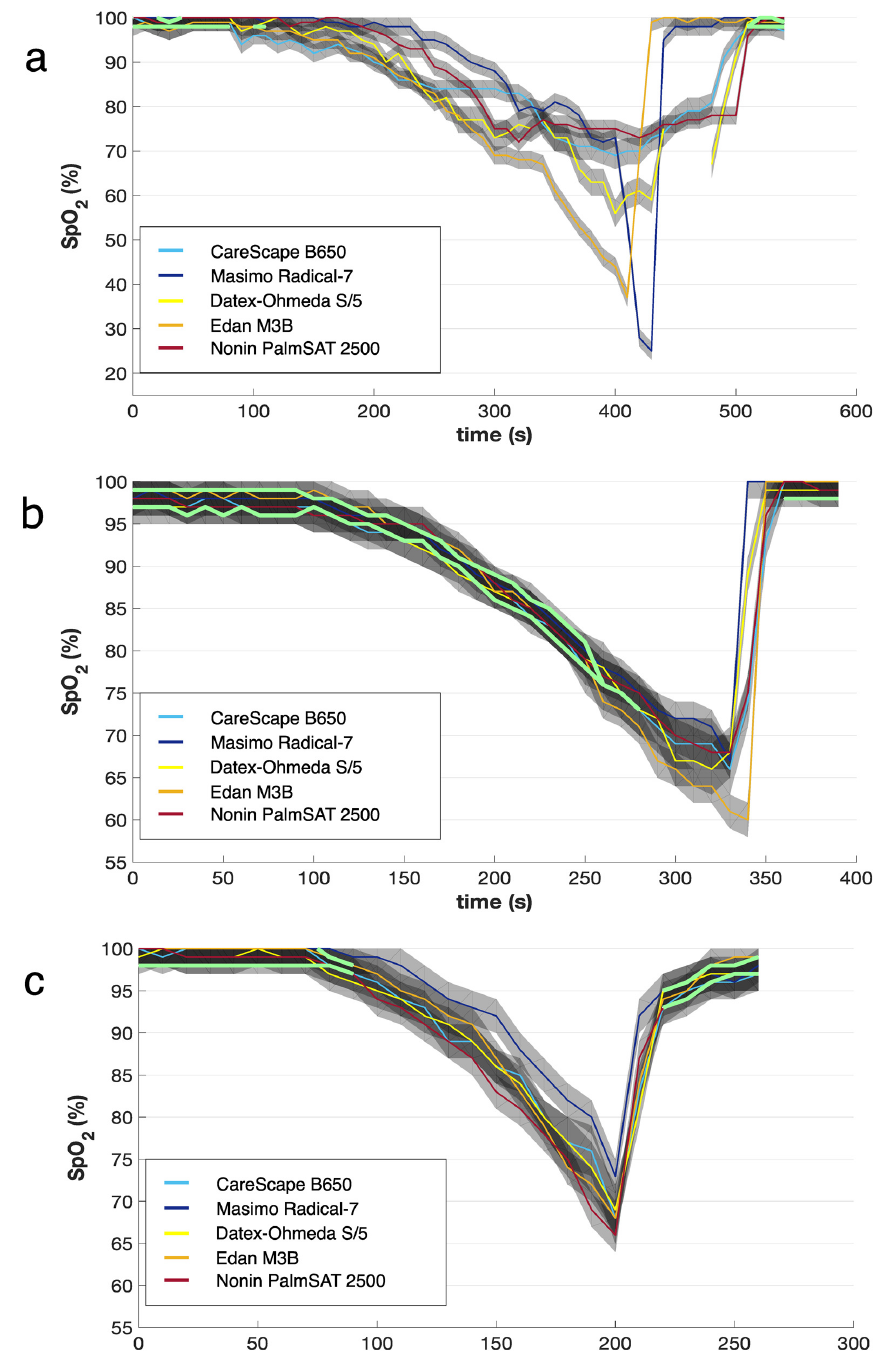
Figure 4. Examples of three individual breathing experiments underwent by three different subjects. The SpO 2 values measured by five different pulse oximeters are presented by color lines. A gray stripe around each line represents the accuracy range of the respective oximeter guaranteed by the manufacturer. Green thick lines represent periods when all five gray stripes overlap, that means all five pulse oximeters showed a value consistent with the others when respecting the accuracies guaranteed by the manufacturer. ( a ) Very short congruent periods; ( b ) long congruent periods lasting 74.4% of experimental time; ( c ) ostensibly long congruent periods were proved to be congruent only in 50% of time; moreover, the congruent segments were present outside the period of rapid changes of SpO 2